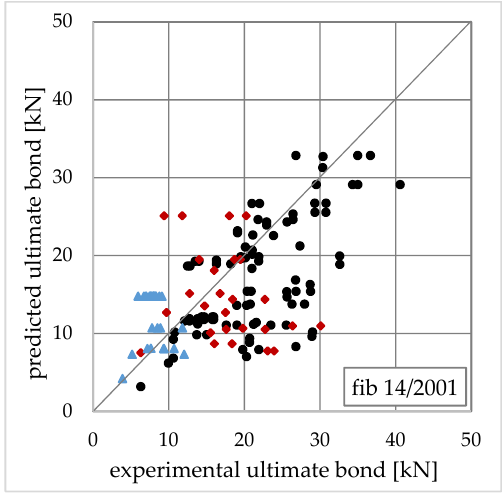
Figure 20. Test vs. predicted bond force using the TR 55/2000 model [33]. Appl. Sci. 2020 , 10 , 8593